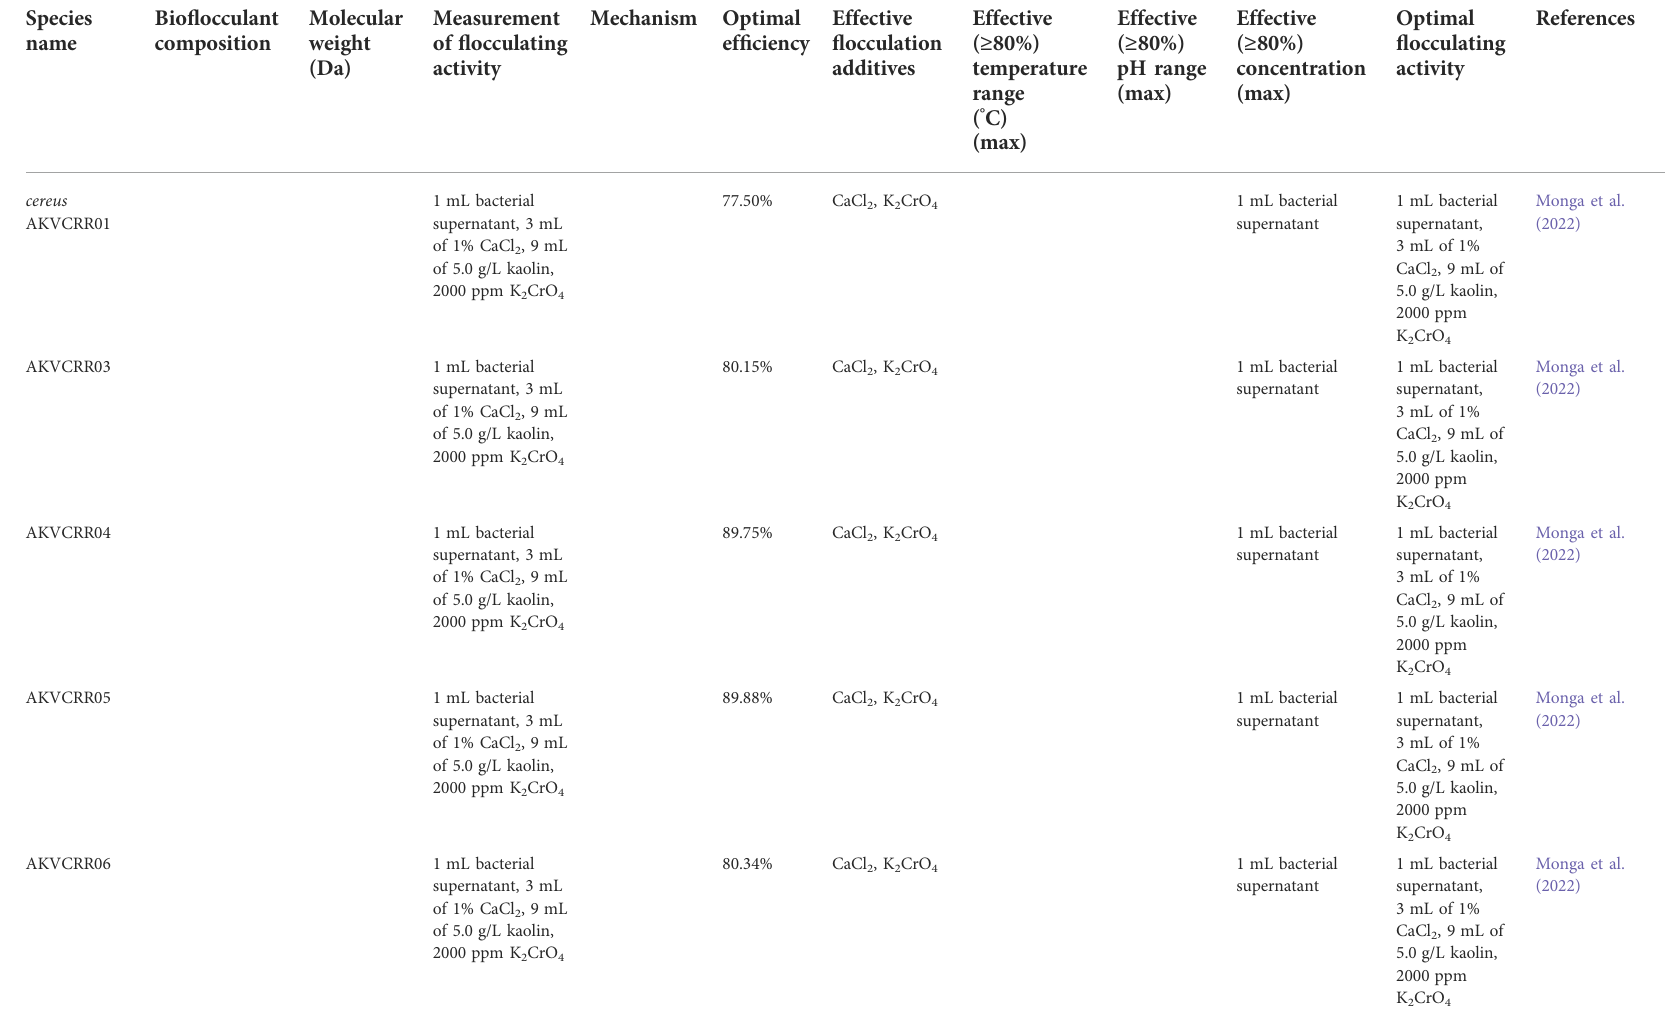
TABLE 1 ( Continued ) Bacillus genera and their bio fl occulant